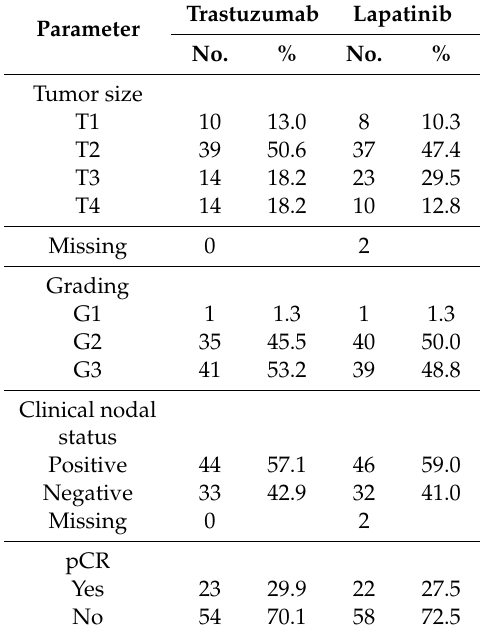
Table A1. Clinical-pathological characteristics of patients in two